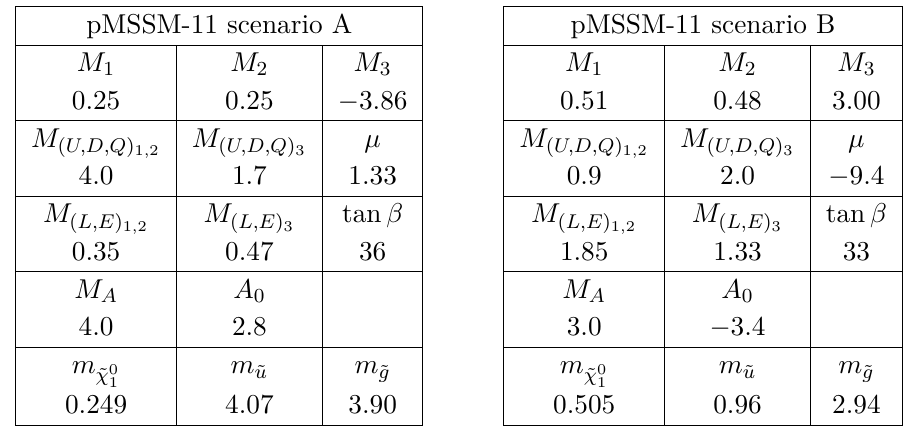
Table 1. Higgs and soft SUSY breaking parameters in our pMSSM-11 benchmark models, together with the relevant resulting physical particle masses. All values, except for tan β , are given in TeV .